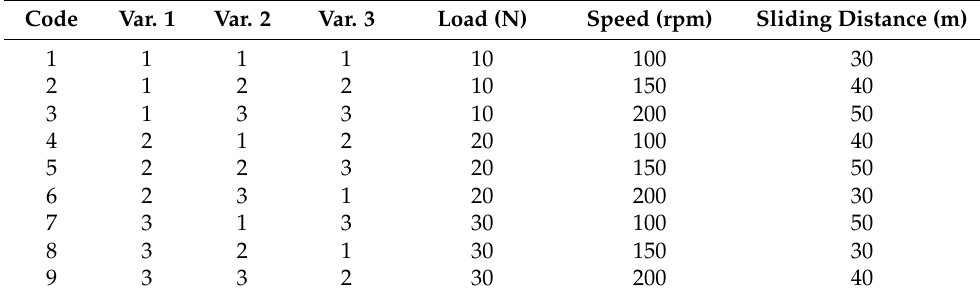
Table 2. Sample codes, variations (Var.) and parameter values for experimental work.